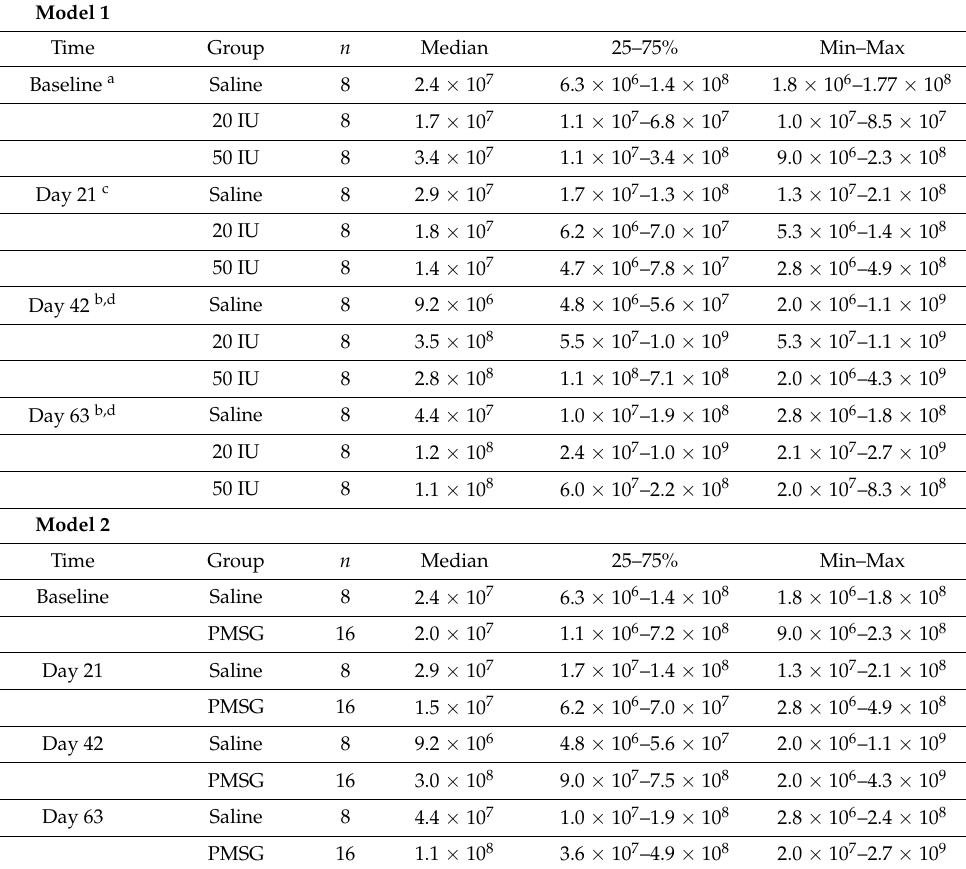
Table 6. Leopard gecko spermatozoa concentrations over time and by treatment group.